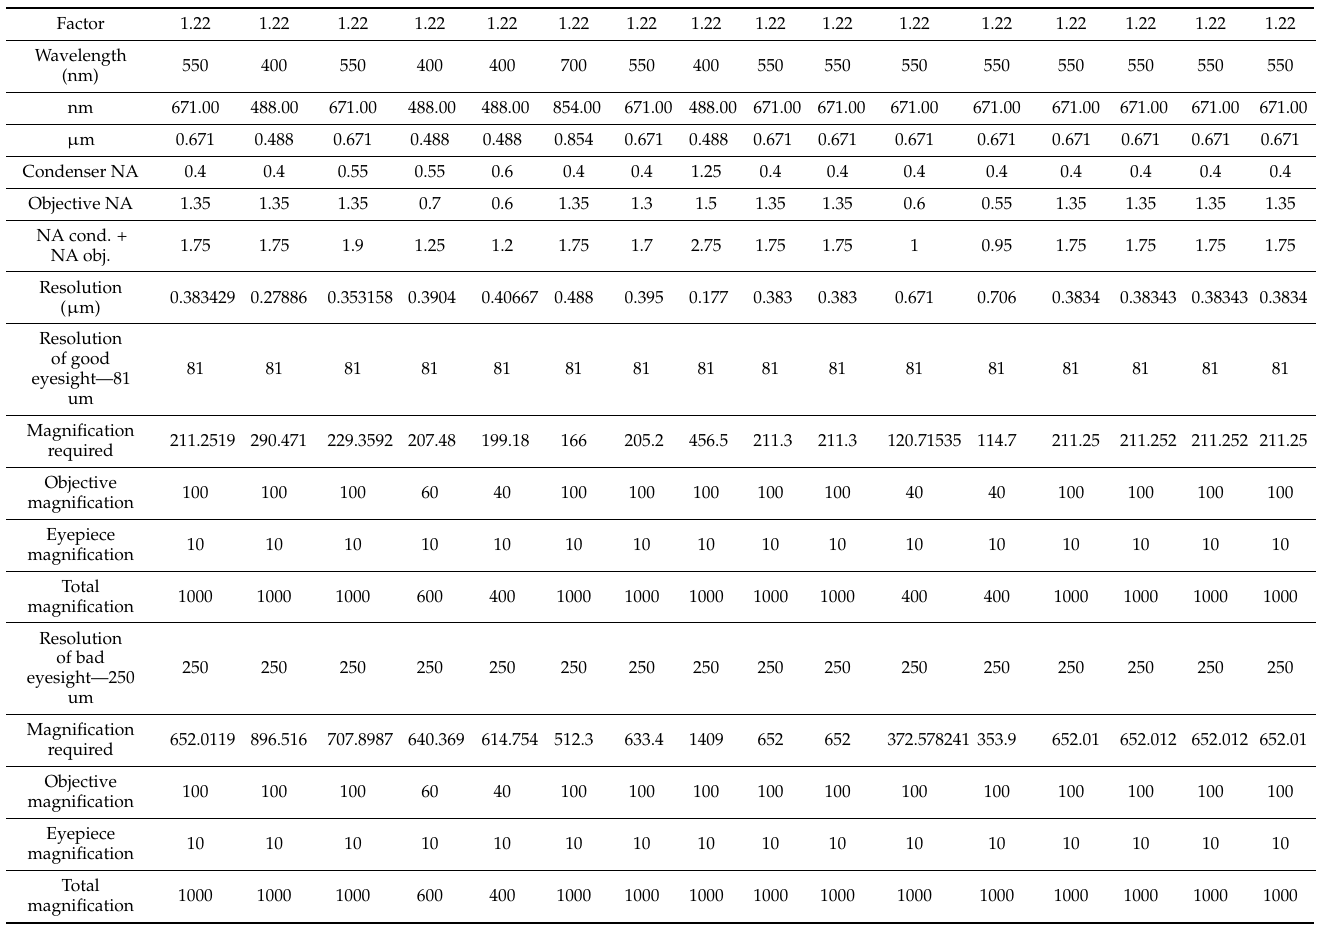
Table A1. Values of recommended magnification for defined parameters of wavelength, NA